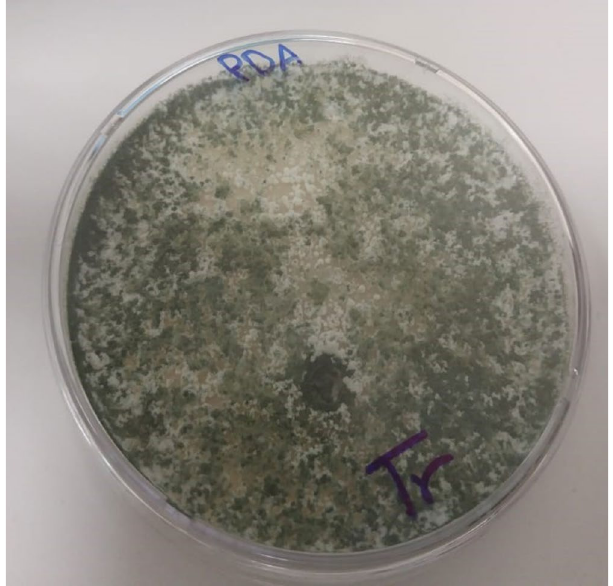
Figure 1. Growth of T. longibraciatum on PDA medium after 4-day incubation period.